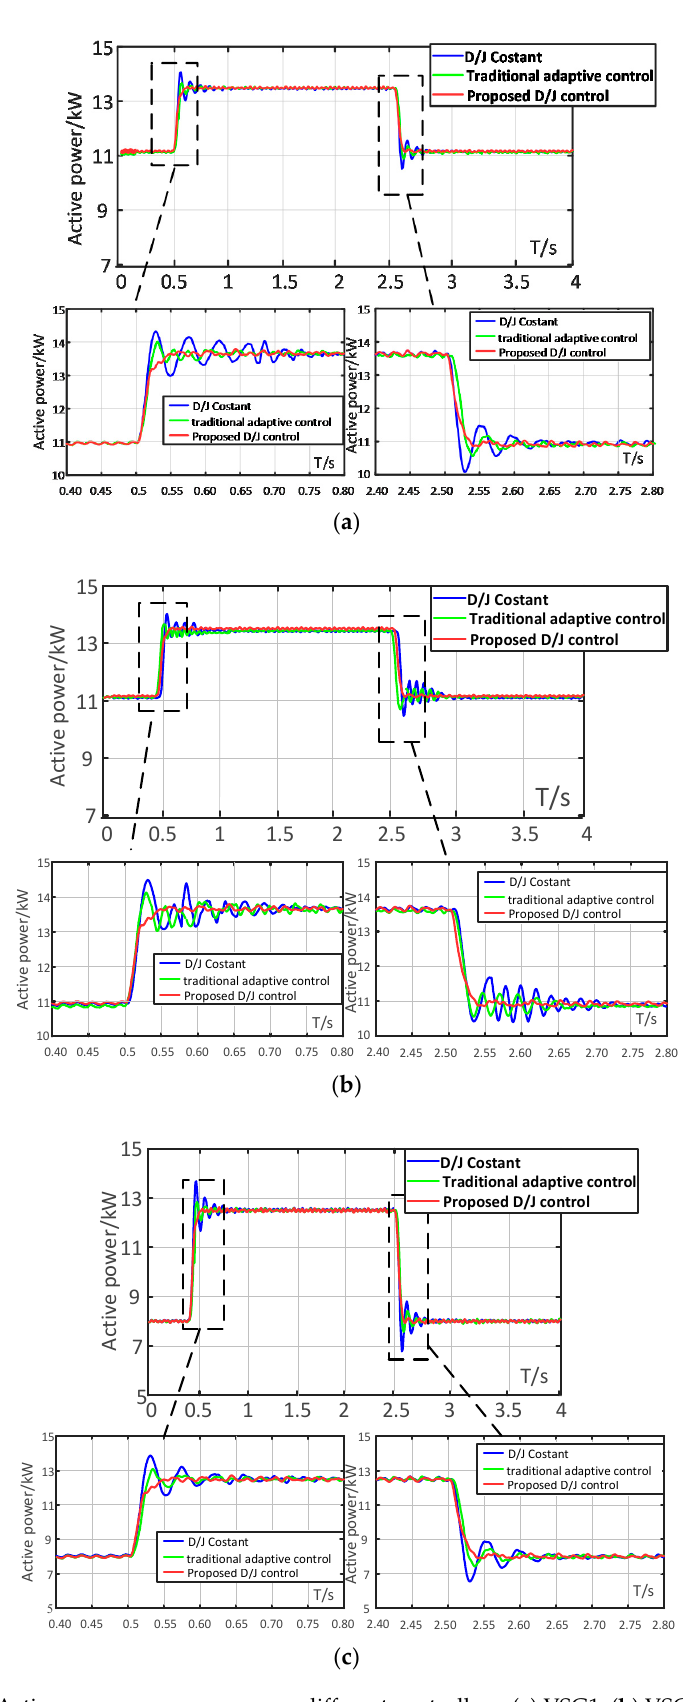
Figure 13. Active power response among different controllers: ( a ) VSG1; ( b ) VSG2; ( c ) VSG3.